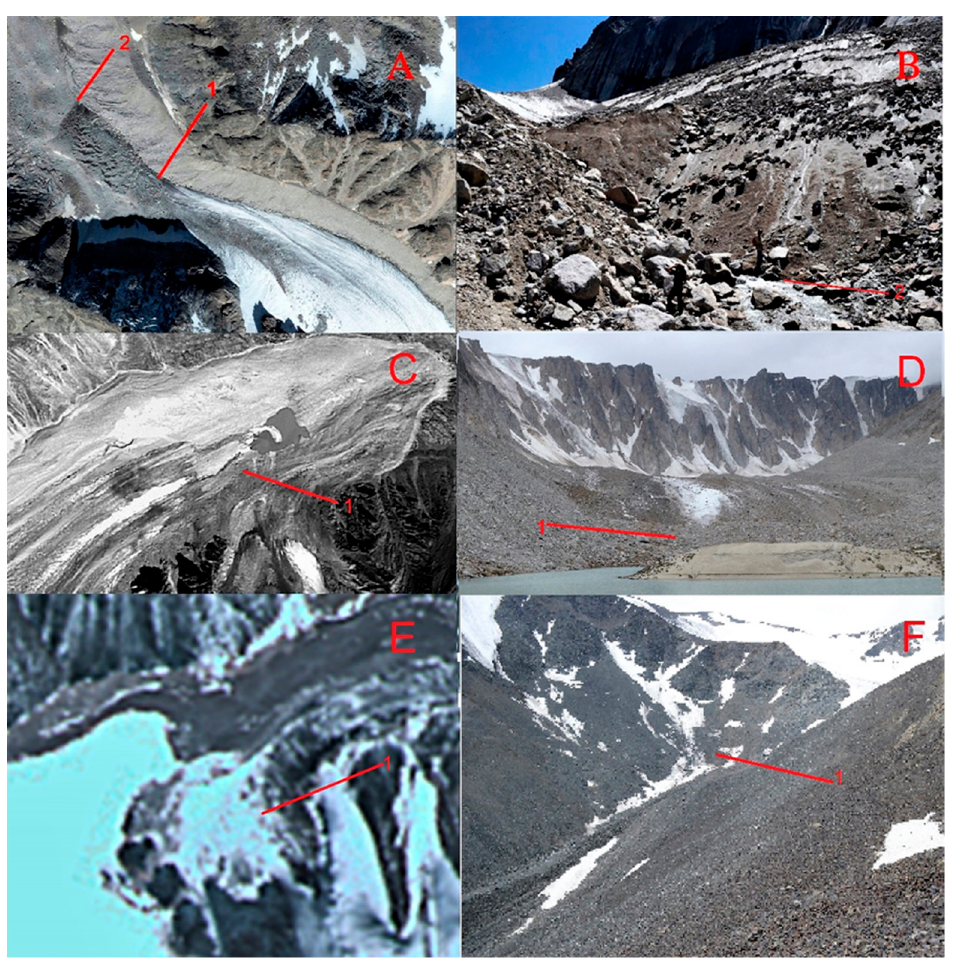
Figure 2. Areas of satellite images that are problematic for glacier delineation and their photographs obtained in situ. ( A , B ) Grigorieva glacier, Ikh Turgen: 1—False glacier edge based on the interpre- tation of the satellite image (World View-2, 22 August 2013), 2—The real edge of the glacier, based on the results of in situ observations (photo 24 July 2015). ( C , D ) Tsengel-Khairkhan, Holtsutiyn-Gol valley: C, 1—The area that looks like a debris-covered glacial snout in the Spot-5 image (7 August 2008), ( D ) 1—The real edge of the glacier, based on the results of field observations (photo 24 July 2016). ( E , F ) Mongun-Taiga, Levyi Mugur valley: ( E ) 1—The area, that looks like a small cirque glacier in the satellite image (Spot-5 19 September 2011), ( F ) 1—The same area in the photo (15 July 2011)-debris-covered dead ice.